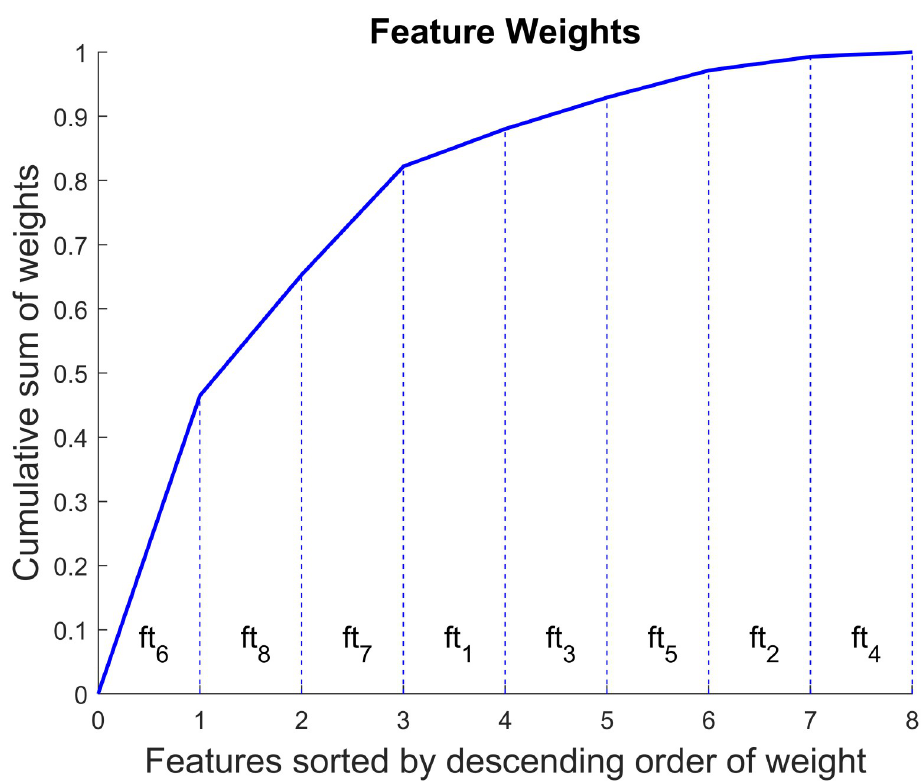
Fig 8. Feature importance in drop classification. The feature numbers refer to those defined in Eq 1. The horizontal axis shows the features sorted in descending order of importance (or weight). The vertical axis shows the cumulative sum of the feature